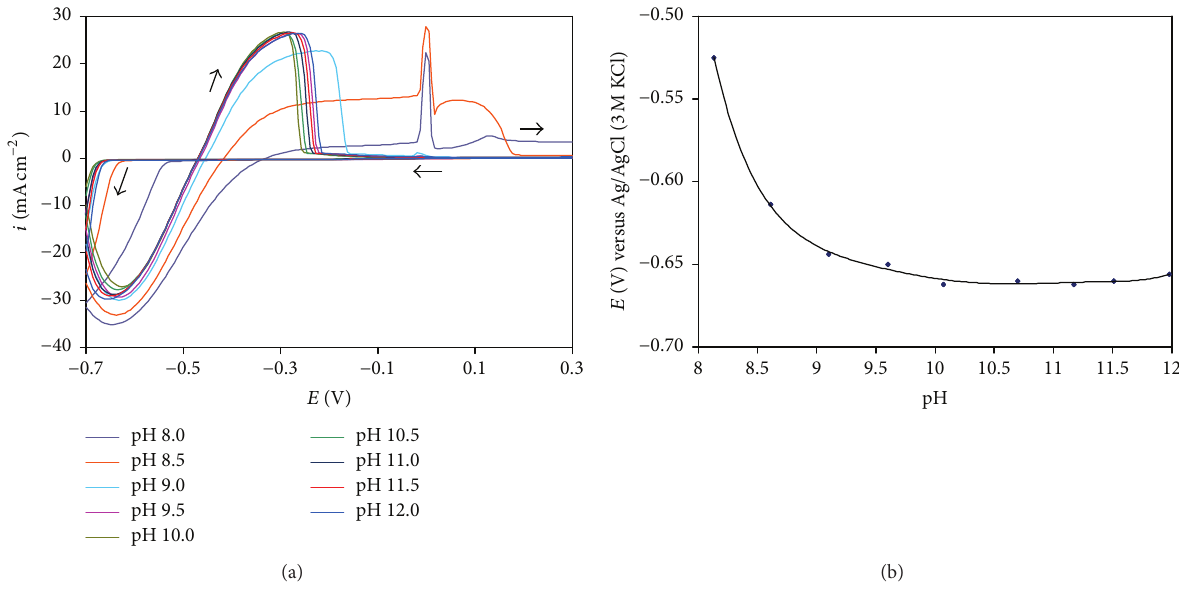
Figure 5: (a) Cyclic voltammograms showing the silver electrodeposition and silver film dissolution in the solutions consisting of 120g/L KAg(CN) 2 , 6g/L KCN, and 120g/L KNO 3 at pH 8–12. (b) The effect of pH of the silver solutions on the onset potential of electrodeposition of silver ion on Pt electrode